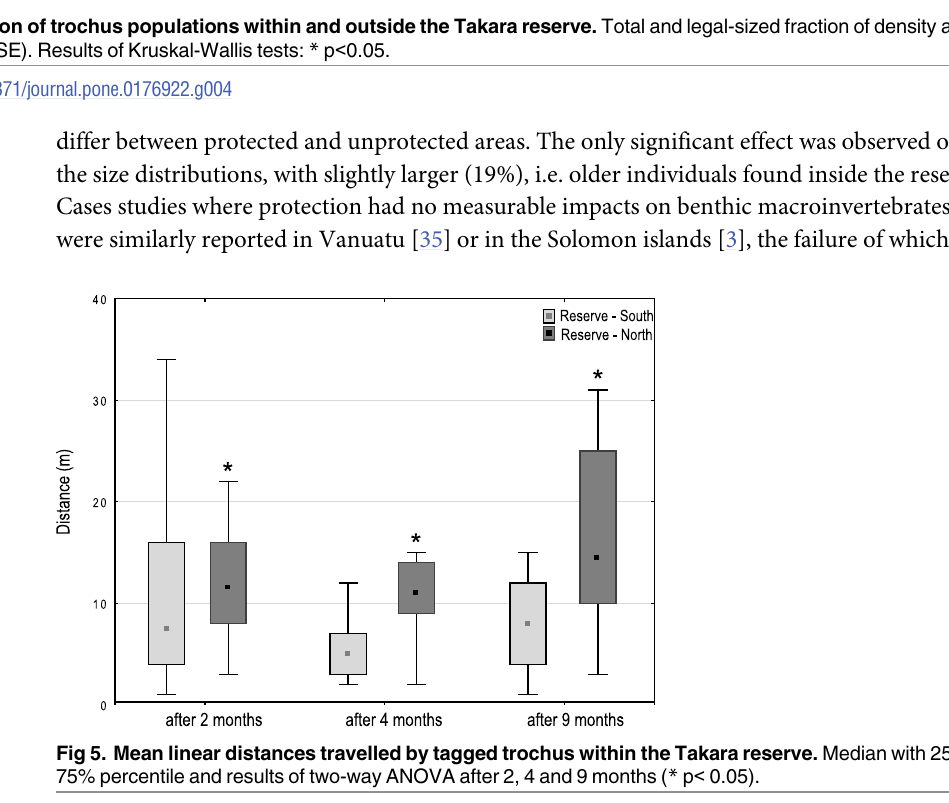
PLOS ONE | https://doi.org/10.1371/journal.pone.0176922 May 2,